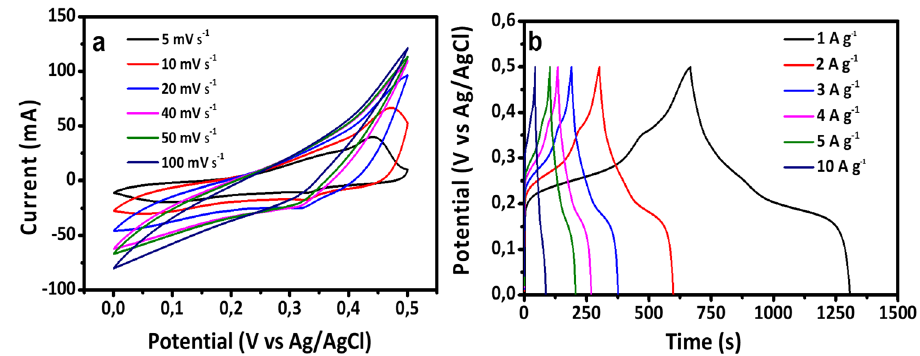
Fig. 9 a CV curves at various scan rates and b GCD curves at distinct specific currents for NiCoMn-Th/200